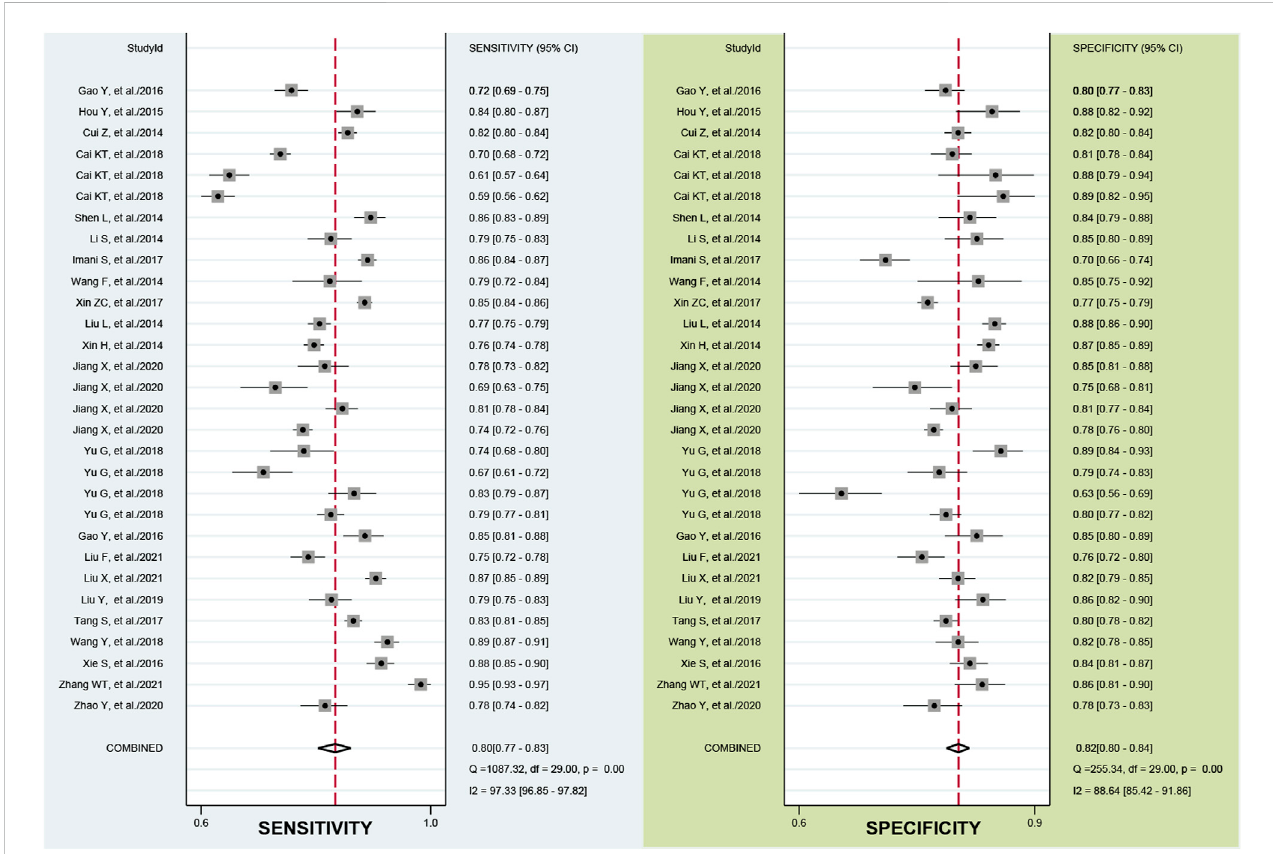
FIGURE 2 Forest plots of the sensitivity and speci fi city of the ncRNA assays. The overall results for negative predictive value (NPV), positive predictive value (PPV), PLR + , PLR − , sensitivity, and speci fi city were 0.79, 0.80, 4.44, 0.25, 0.80, and 0.82, respectively.